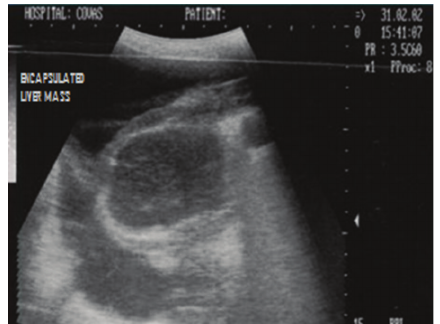
Figure 30: Transverse ultrasonogram (2D) of liver in a nine-year- old spayed female, German shepherd dog revealing two hypere- choic homogenous circular nodular masses measuring 55mm and 29mm.